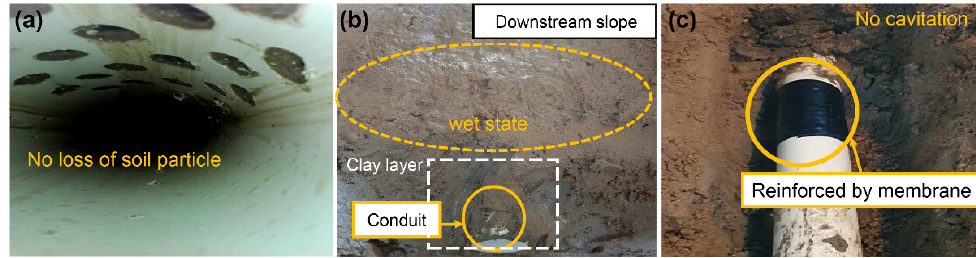
Figure 4. Reinforcement condition of current model (Case 1—Reinforcement): ( a ) no loss of soil par- ticles inside conduit, ( b ) formation of wide wet area outside the conduit, ( c ) reinforced crack area using membrane.